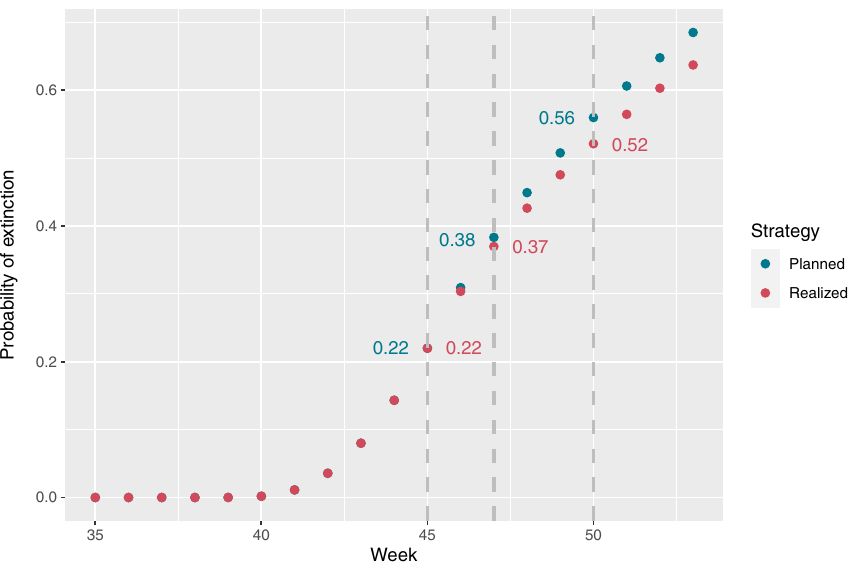
Figure 4. Probability of extinction for planned and realized